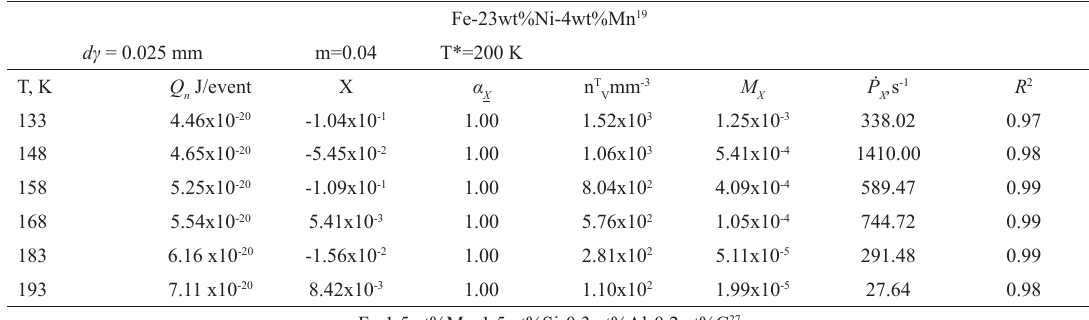
Table 1: Time-dependent